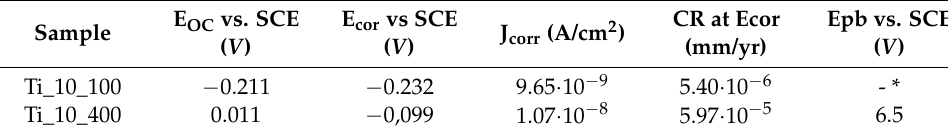
Table 7. Summary of the corrosion resistance